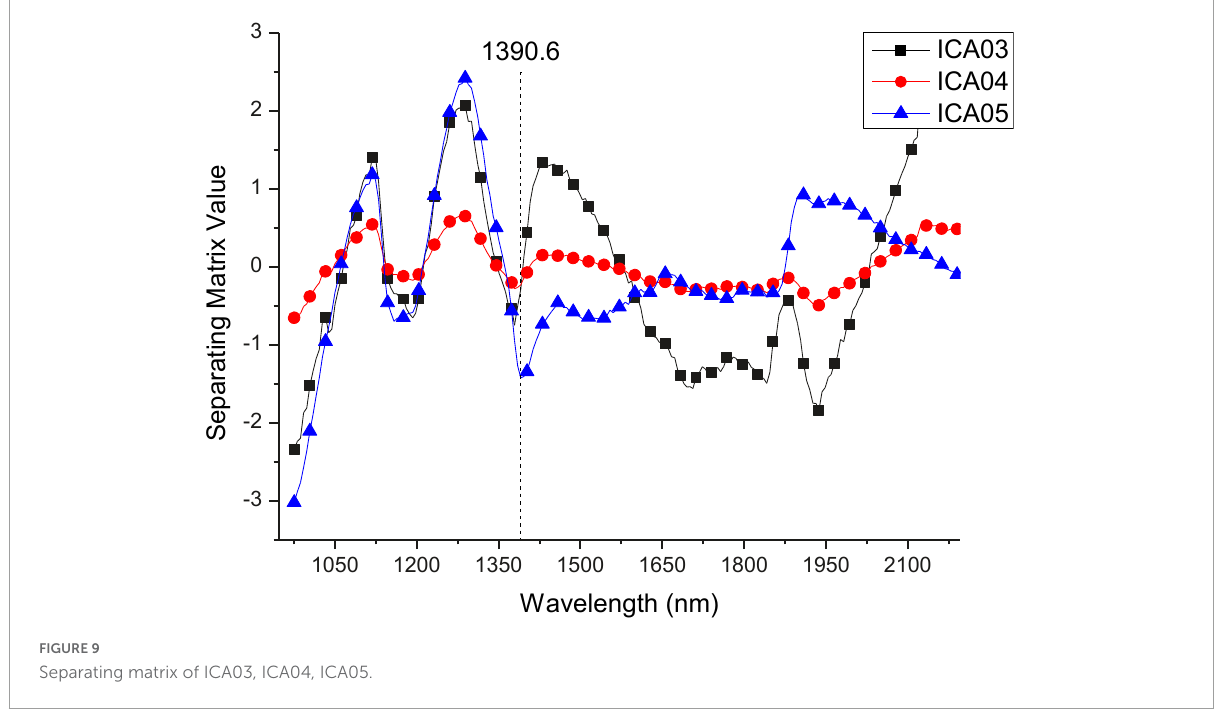
FIGURE9 Separating matrix of ICA03, ICA04, ICA05.